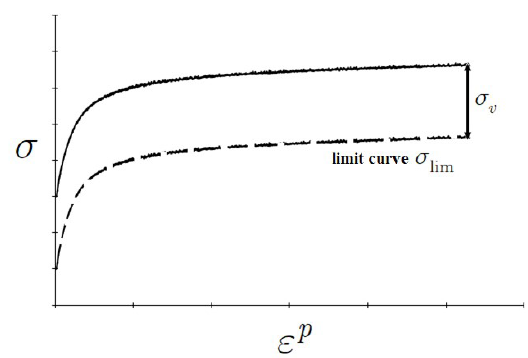
Figure 4. Tensile test with different strain rates - viscous effect.